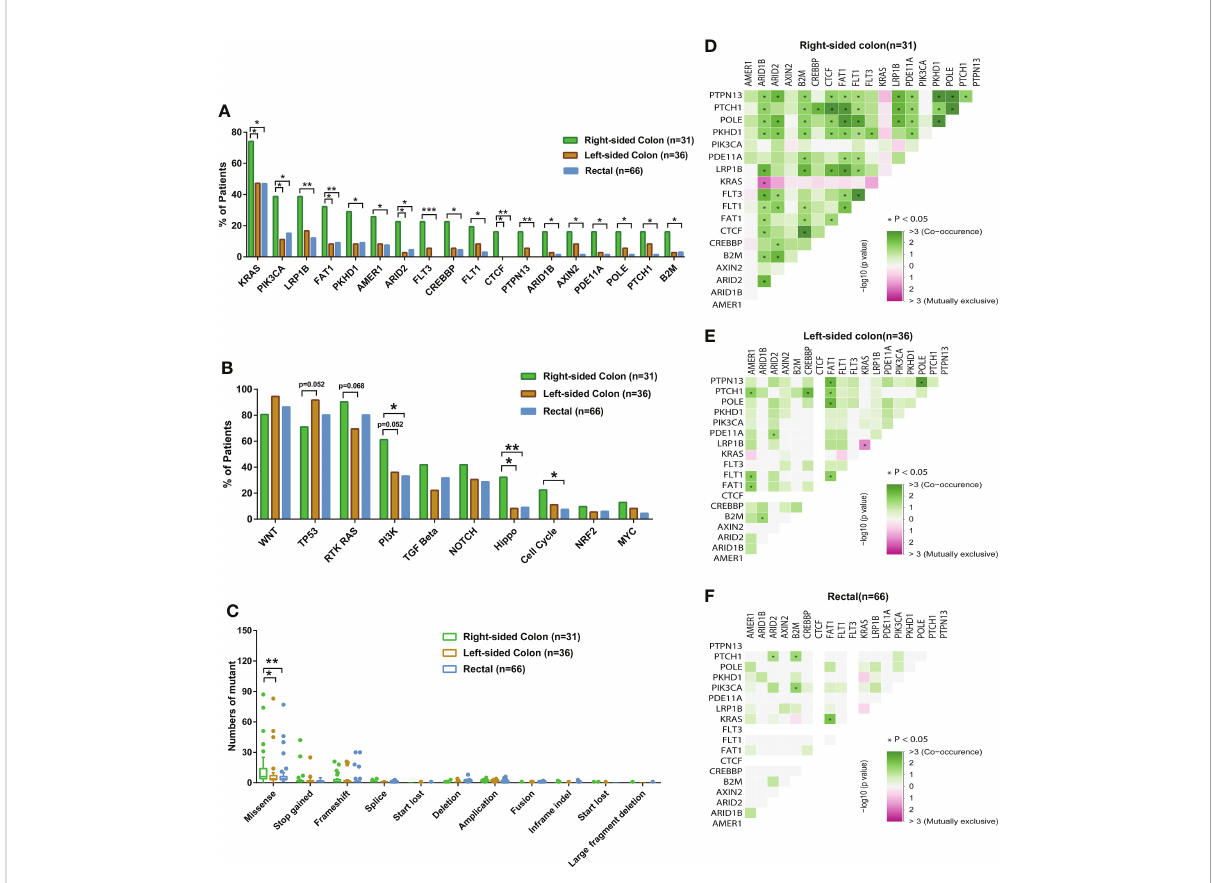
FIGURE 4 The comparisons of somatic mutation characteristics and mutation types among colorectal cancer patients with different tumor anatomic locations and genetic interaction analysis of different tumor anatomic locations. (A, B) The bar plots comparing somatic mutation and pathway alteration rates among patients with different tumor anatomic locations (right-sided colon, N=31; left-sided colon, N=36; rectal, N=66). (C) The box plots comparing differences in mutation types among patients with different tumor anatomic locations (right-sided colon, N=31; left-sided colon, N=36; rectal, N=66). (D-F) Genetic interaction analysis of different tumor anatomic locations. *p < 0.05, **p < 0.01, ***p <